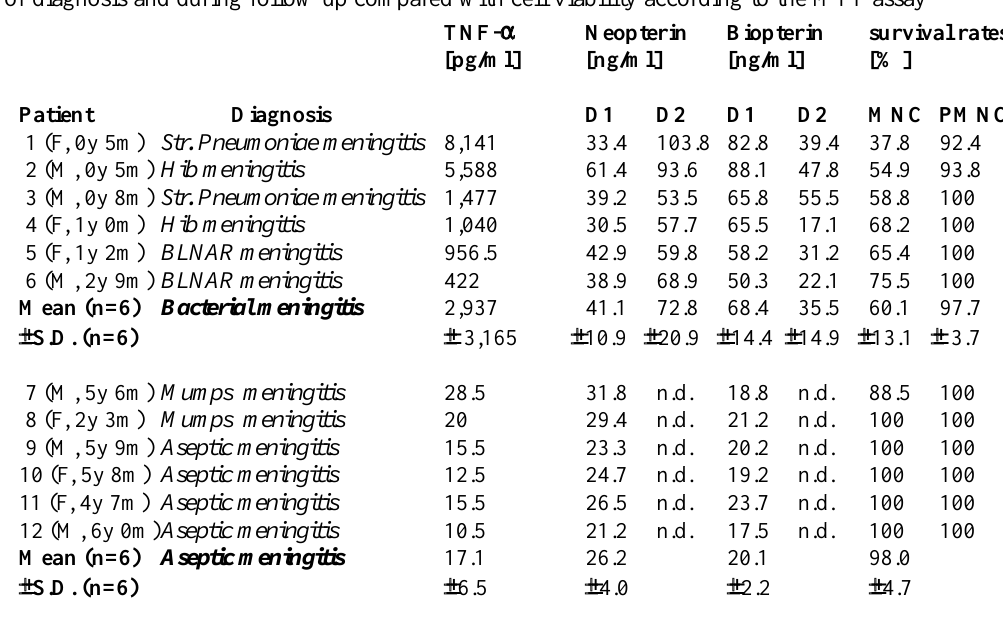
Table 2: Cerebrospinal fluid concentrations of tumor necrosis factor- a (TNF- a) , neopterin and biopterin on the day of diagnosis and during follow-up compared with cell viability according to the MTT